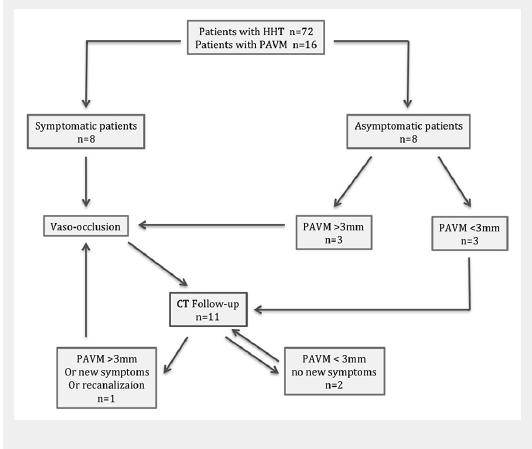
Figure 2 Treatment for symptomatic or >3 mm pulmonary arteriovenous malformations and